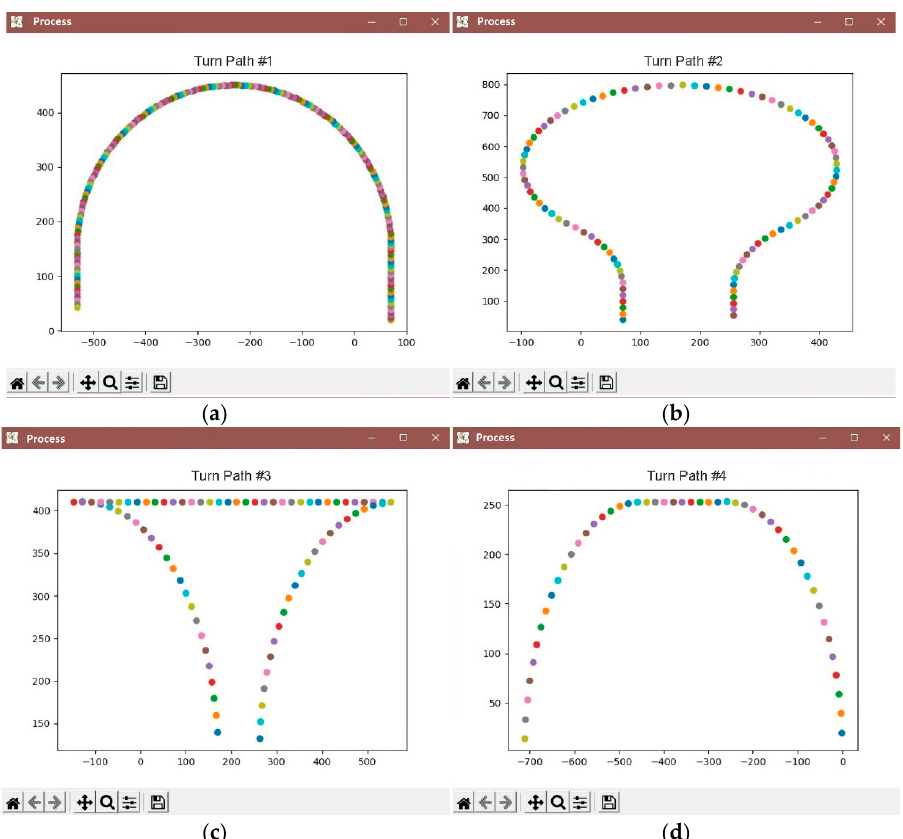
Figure 15. The specified typical trajectories of the platform turn in an intensive garden: a turn through a row ( a ), a turn of a large radius ( b ), a turn using reverse gear ( c ), a turn with a straight line ( d ).